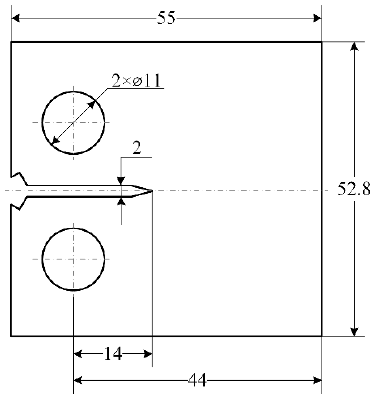
Figure 2. Compact tensile specimen (mm).